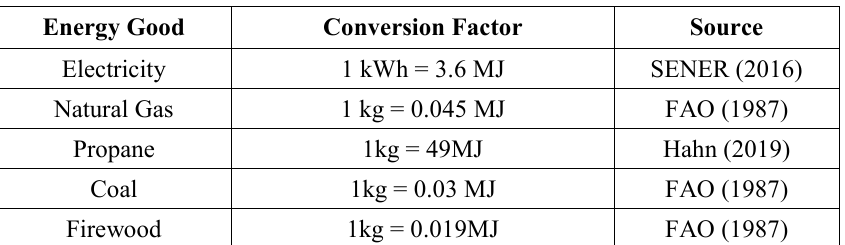
Table 1. Conversion Factors for Different Energy Goods